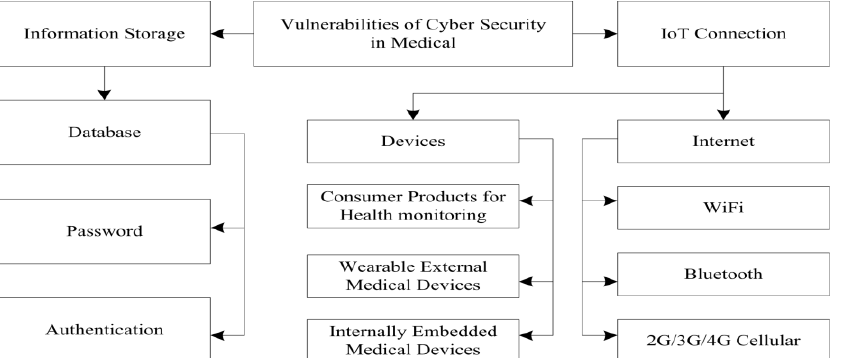
Figure 16. Main vulnerabilities of cybersecurity in the medical domain [89]. Abbreviations used: IoT, Internet of Things; and “N”G, Nth-Generation cellular network.